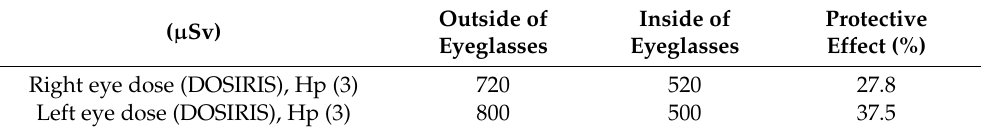
Table 3. Protective effect of Pb eyeglasses used for 9 months during CTF procedures (47 procedures). Outside of Inside of ( µ Sv) Eyeglasses